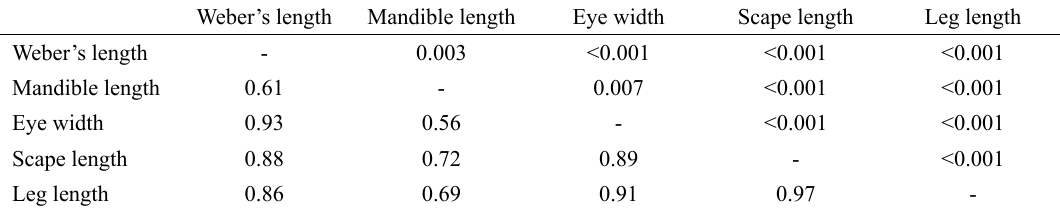
Table 1. Correlation coefficients in ants morphological